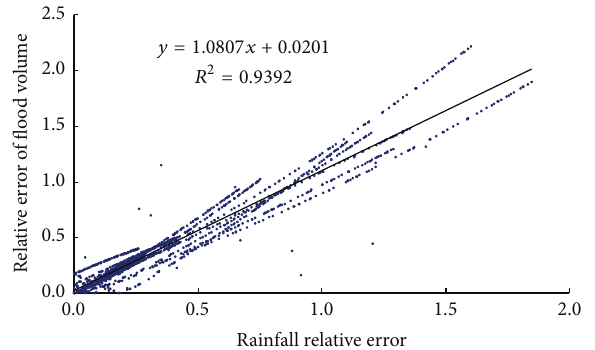
Figure 5: Relationship between relative error in predicted flood vol- ume and rainfall relative error.